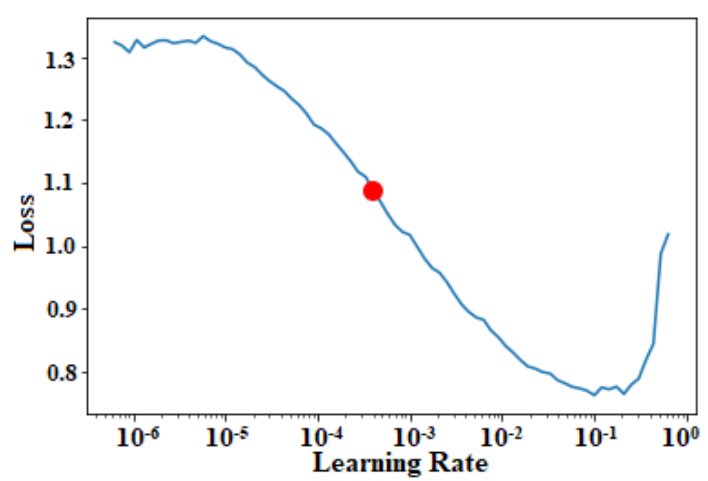
Figure 12. Plot between the learning rate and validation loss.